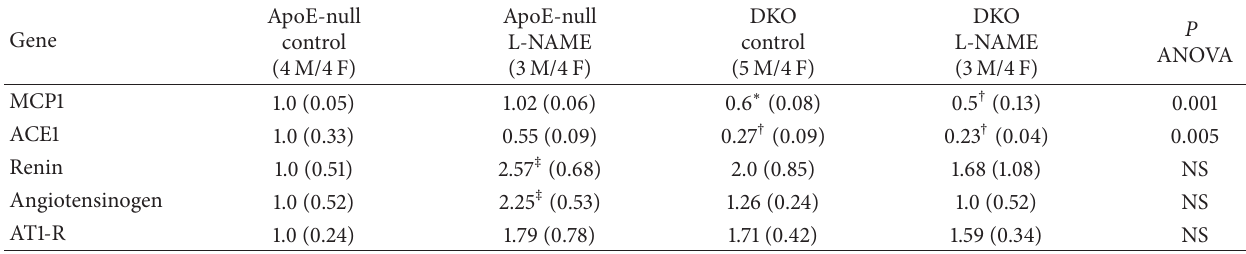
∗ P < 0.05 versus control ApoE-null mice. † P < 0.01 versus control ApoE-null mice. ‡ P < 0.05 versus control ApoE-null mice by Student’s t